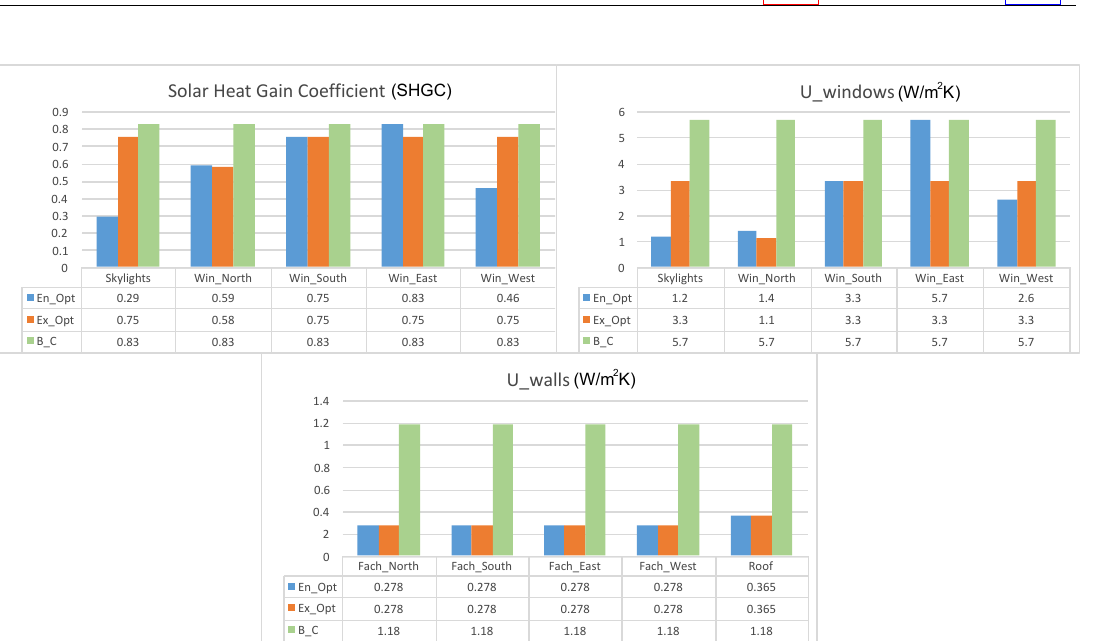
Figure 10. Best parameters for each component of the